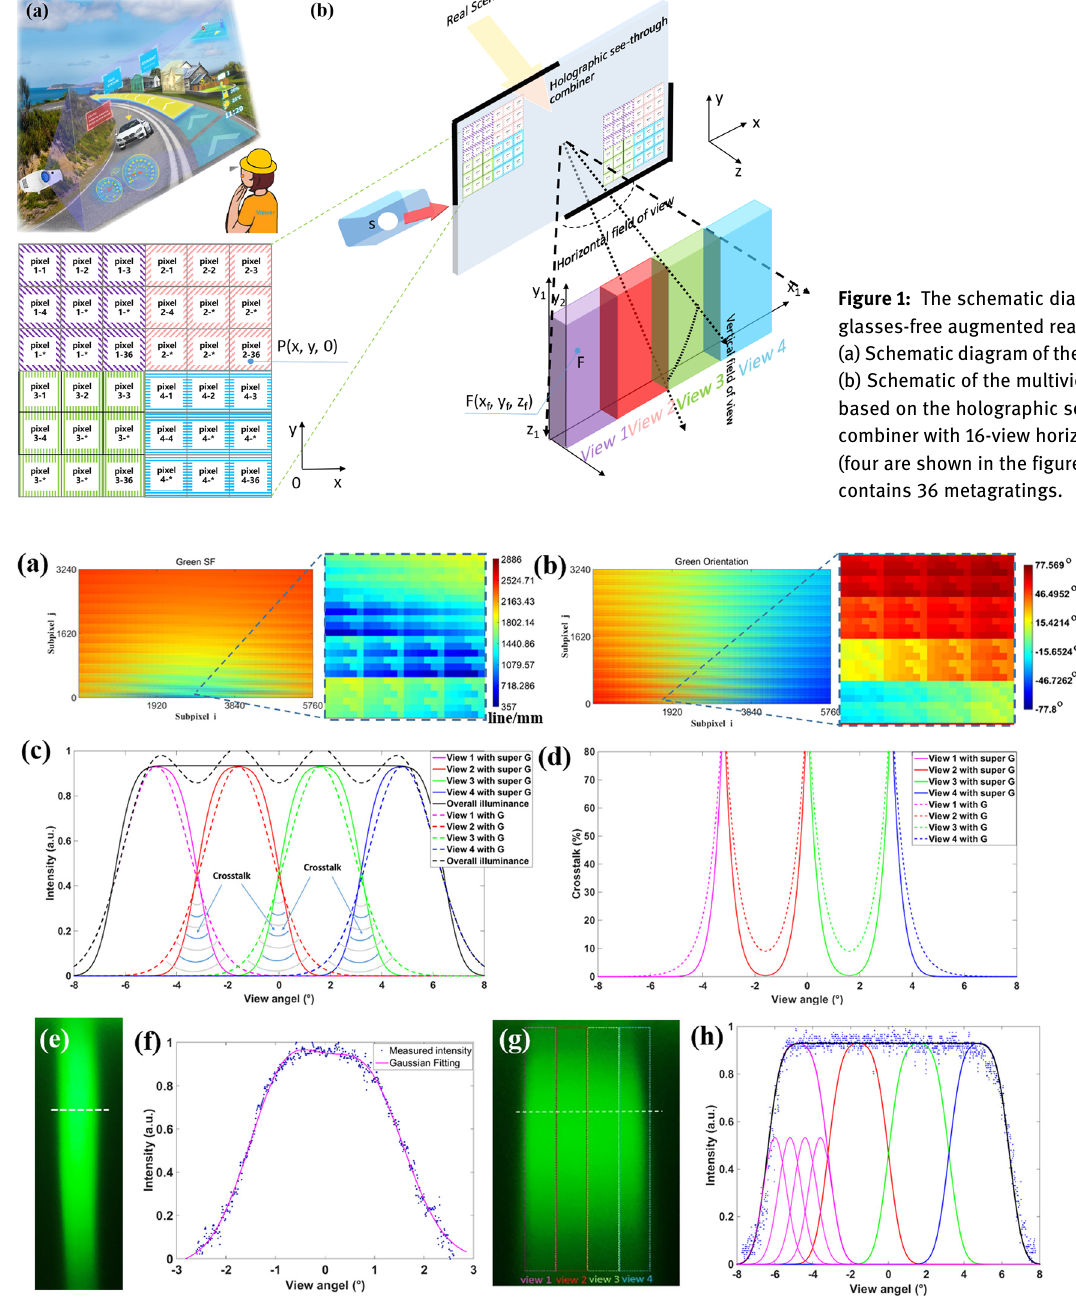
Figure 2: (a) The spatial frequency and (b) the orientation variation of the metagratings designed according to the wavelength of 540 nm. The inserts illustrate the variation of structural parameters in a voxel that contains 16 pixels for 16 views. (c) The comparison of irradiance pattern with traditional Gaussian distribution (dotted line) and proposed super Gaussian distribution (full line). The crosstalk as illustrated in the shadow region is smaller benefit from the steepened slope. (d) The comparison of crosstalk between traditional Gaussian distribution and proposedsuperGaussiandistribution.(e)Thephotooftheirradiancefromoneview.(f)Theintensitydistributioninthehorizontaldirectionof the view shownin (e). (g) The photo of the irradiance from four views. (h) The intensity distribution in the horizontaldirection of the four views shown in We consider four views with angular separations of 3 ° . Gaussian distribution are illustrated in Figure 2(c). The The irradiance patterns of Gaussian distribution and super overlapped regions illustrate crosstalk or ghost images that